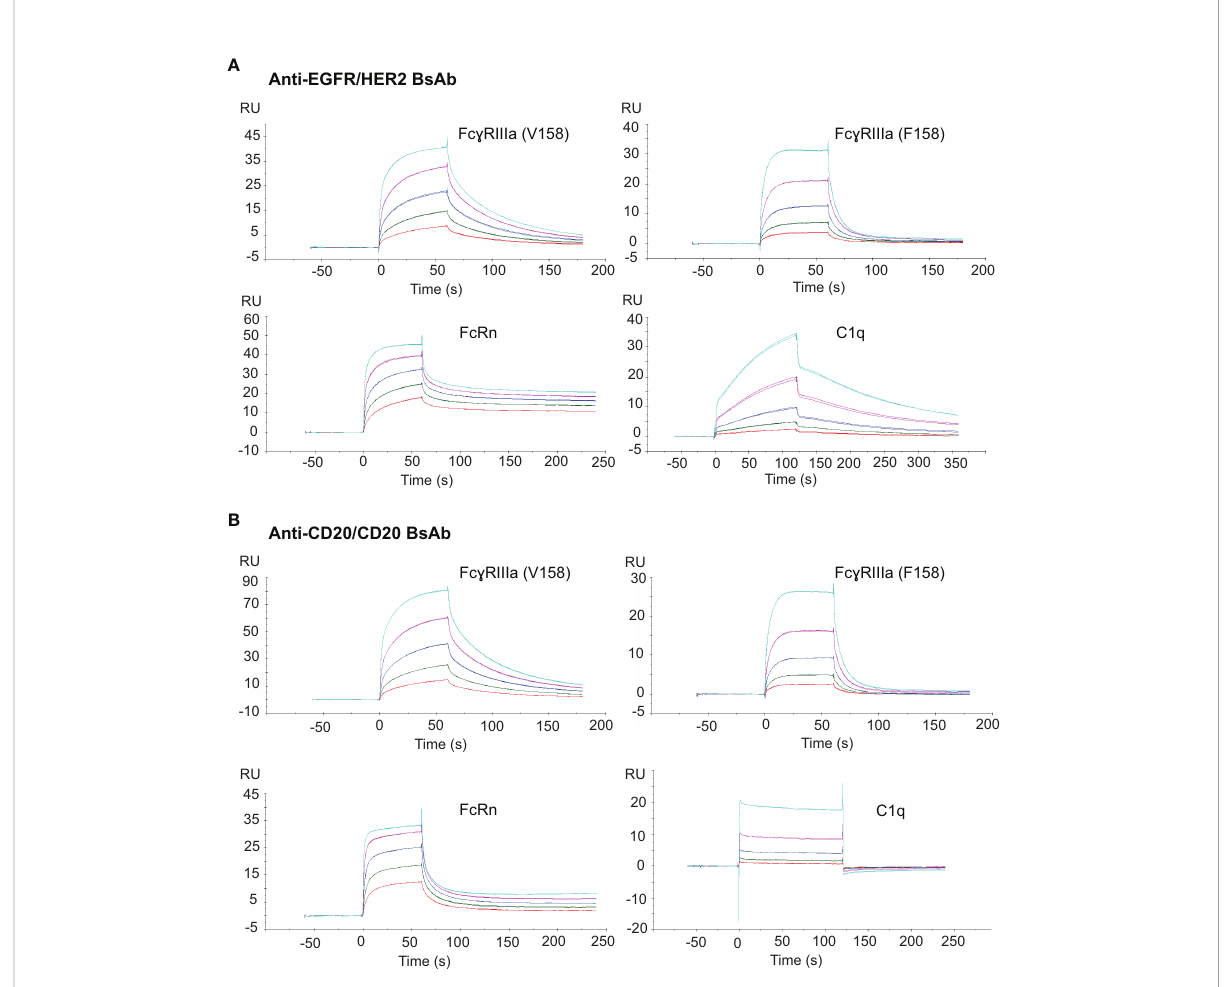
FIGURE 9 Fc binding activity of the two BsAbs to their target proteins. (A) SPR sensograms of soluble anti-EGFR/HER2 BsAb to chip-capture Fc ɣ RIIIa (V158), Fc ɣ RIIIa (F158), FcRn and the binding of this BsAb coated on protein-L chip to a soluble C1q protein. (B) SPR sensograms of soluble anti- CD20 BsAb to chip-capture Fc ɣ RIIIa (V158), Fc ɣ RIIIa (F158), FcRn and C1q protein. All Fc receptor SPR bindings were done in